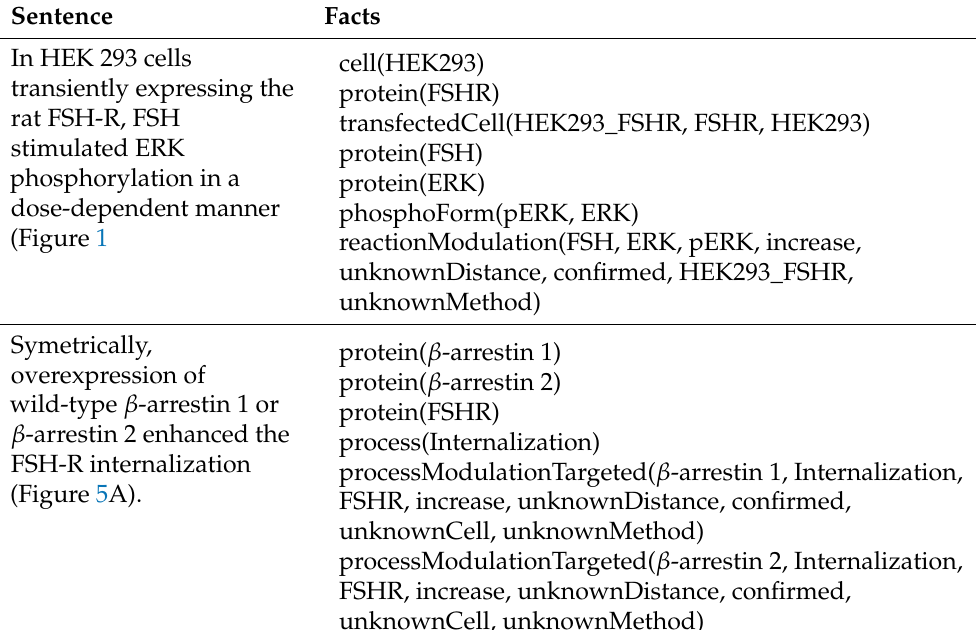
Table 2. Examples of sentences and corresponding facts. Abbreviations: HEK293, human embryonic kidney 293 cells; FSHR, follicle-stimulating hormone receptor; ERK, mitogen-activated protein kinase; β 2AR, beta-2 adrenergic